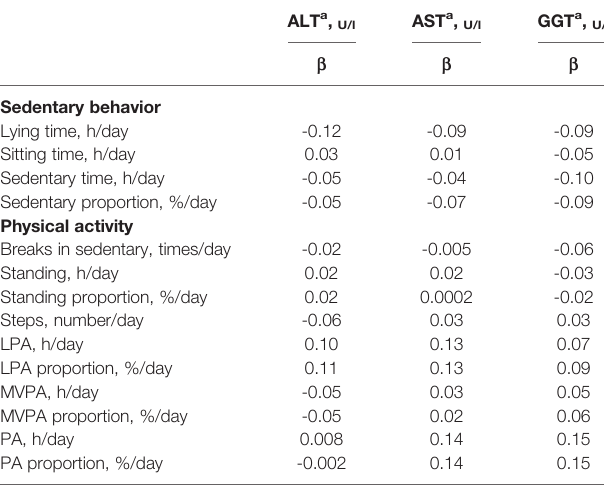
TABLE 5 | Age, sex and BMI-adjusted linear mixed regression estimates (standardized b coef fi cients) between circulating liver enzymes (ALT, AST, GGT) and sedentary behavior and physical